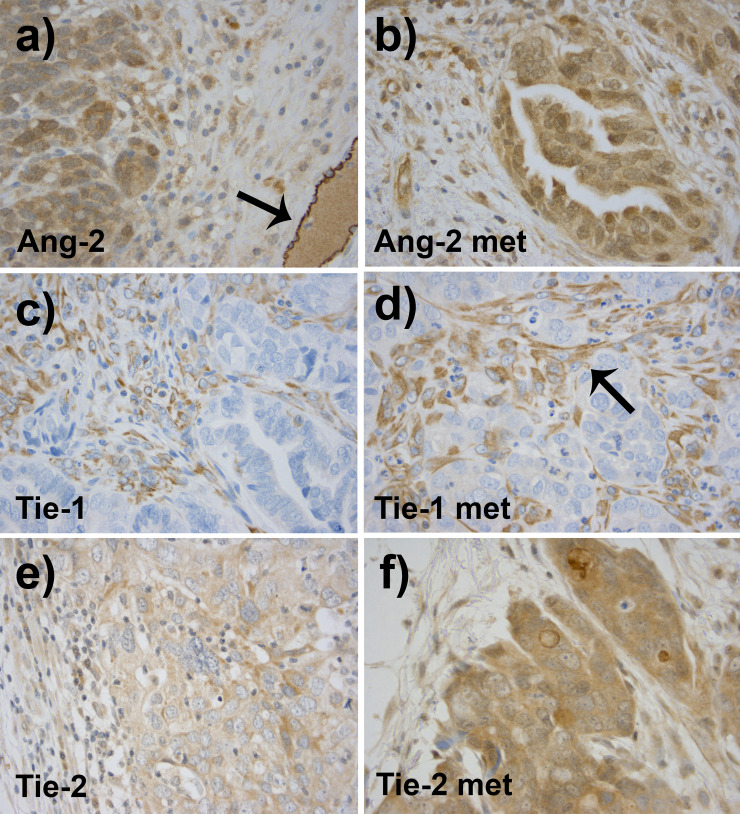
As compared to the primary tumors, related omental metastases showed stronger expression of Ang-2 (a and b) and Tie-2 (e and f). Primary tumors are shown on the left column and related metastases on the right. The vascular endothelial expression was strong in Ang-2 (black arrow in a). Tie-1 expression did not differ significantly between the primary and the distal metastatic tumors (c and d). Tie-1 was expressed in the tumor stroma (black arrow in d).